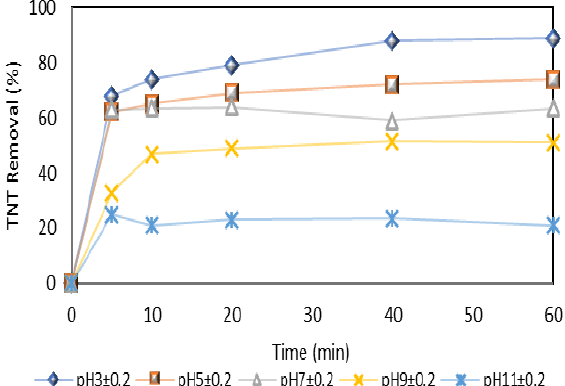
Fig. 3. Effect of UV radiation time at different pH levels on TNT